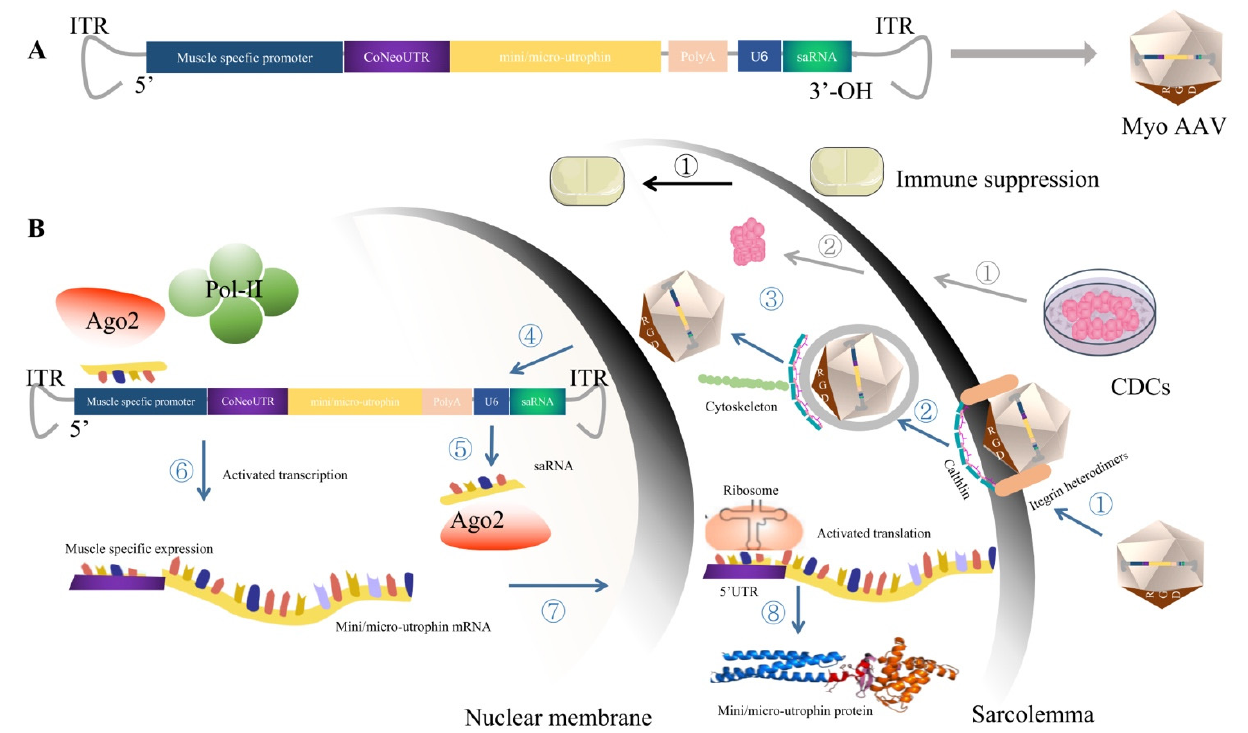
Figure 3. Schematic diagram of CDCs, immune suppression and MyoAAV carrying optimized mini/micro-utrophin expression cassette. ( A ) Overview of the MyoAAV carrying an optimized mini/micro-utrophin expression cassette. The mini/micro-utrophin expression cassette use the muscle specific promoter to regulate the codon-optimized mini/micro-utrophin, and use a U6 promoter to control the rational designed saRNA, which could form an active complex with Ago 2 and driven the complex to the location of the employed muscle specific promoter and activate the transcription of mini/micro-utrophin by recruiting the transcription factors. In addition, CoNeoUTR was added after the muscle specific promoter sequence to activate the translation of the mini/micro- utrophin. ( B ) Schematic diagram of CDCs, immune suppression and MyoAAV carrying the optimized mini/micro-utrophin expression